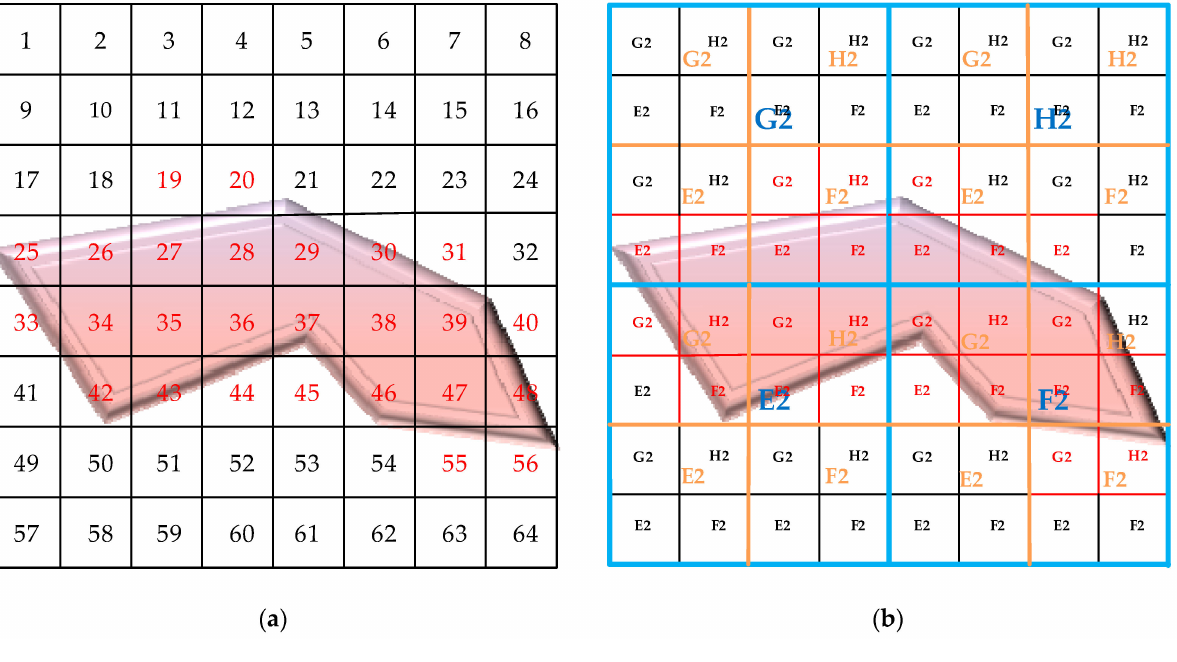
Figure 3. Comparison of octree grid and standard grid. ( a ) Standard grid subdivision model, and ( b ) Octree grid partition model.